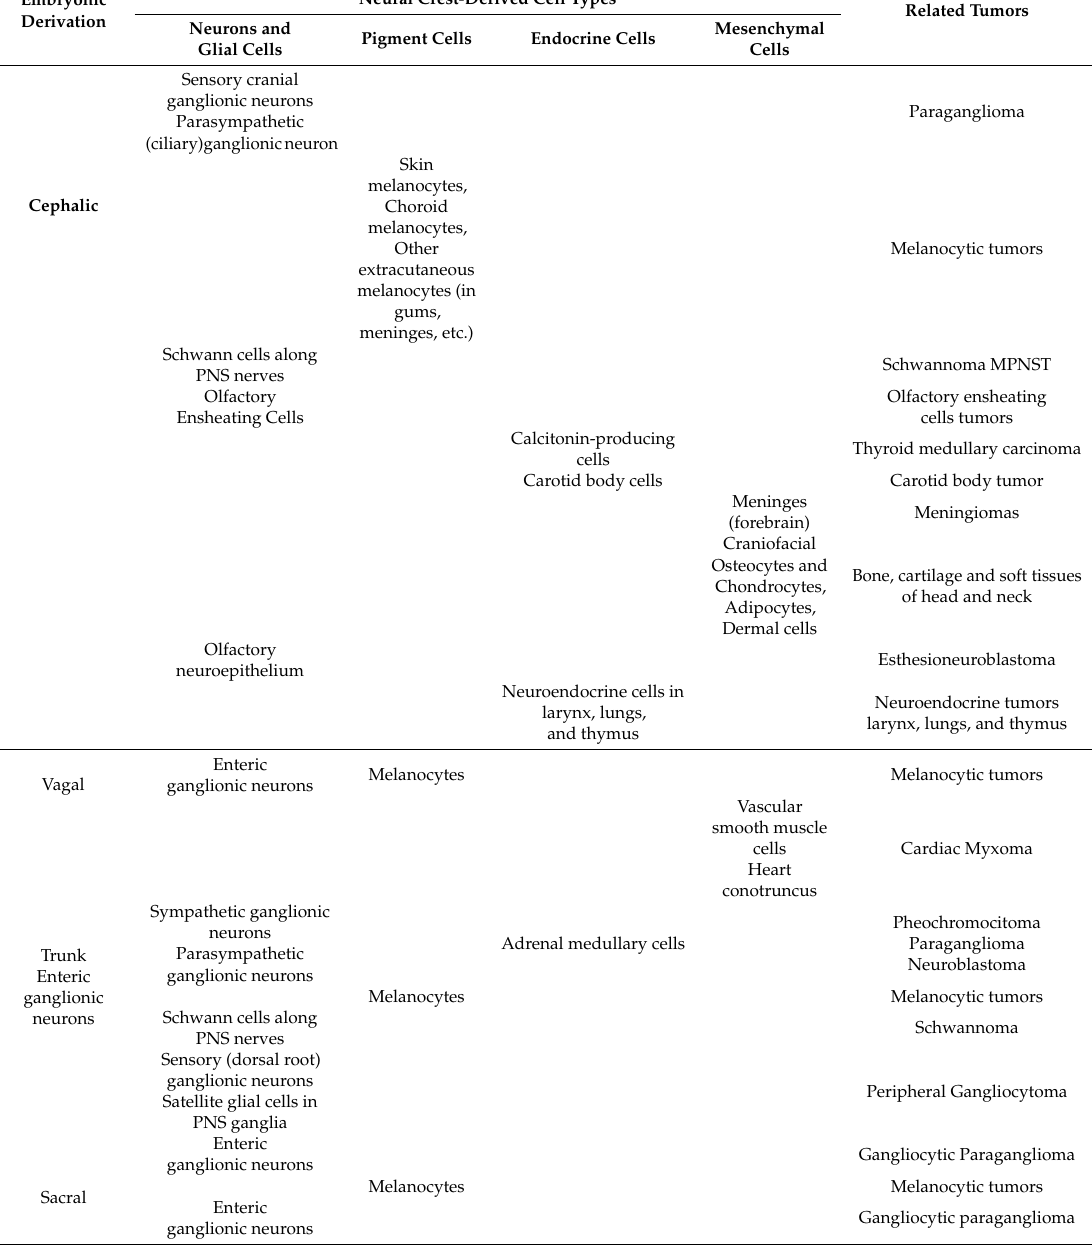
Table 1. Neural crest-derived cell types and